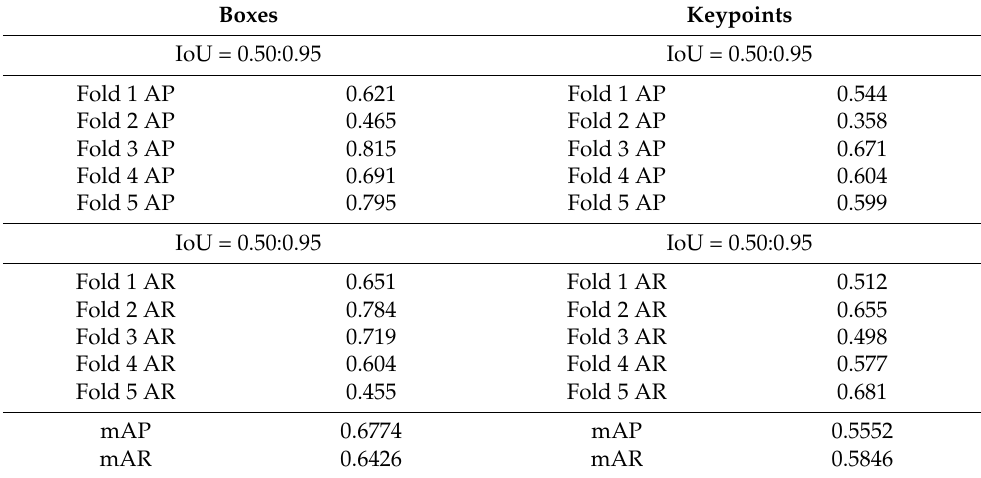
Table 2. Evaluation of the testing